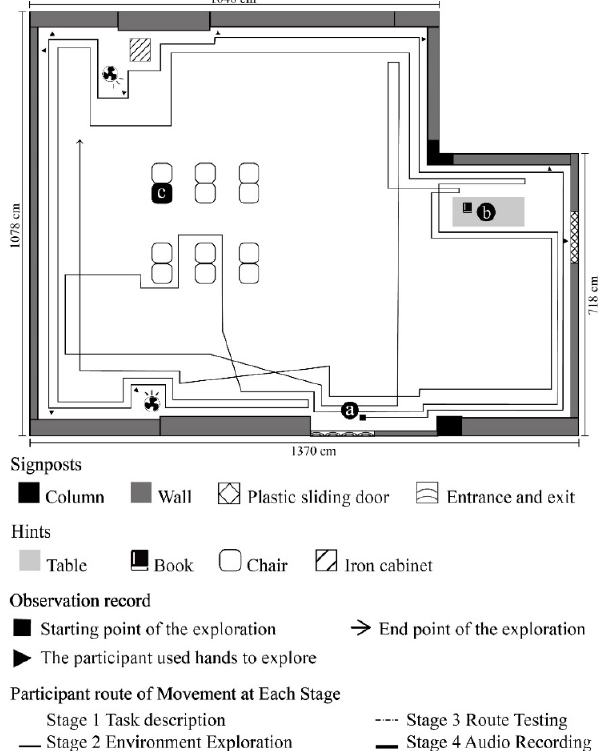
Figure 5. A3 participant’s route of movement at each stage.